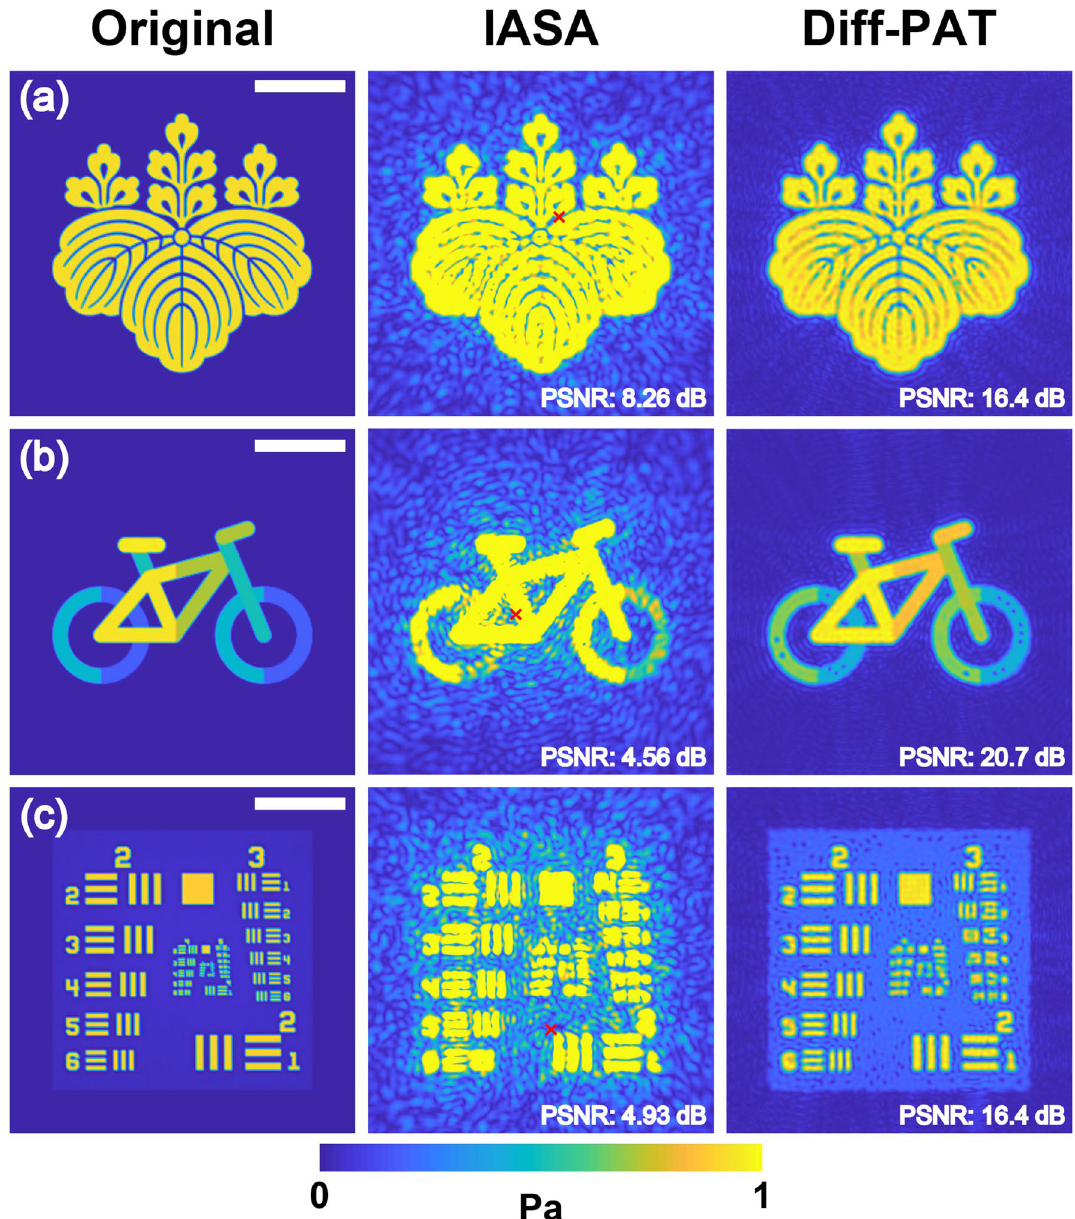
Figure 5. Comparison of acoustic holograms optimised using Diff-PAT and IASA. The resolution of the original image is 256 256 pixels. An underwater 2 MHz transducer with a 35 mm diameter was assumed, and × the pixel size was set to 150 µ m . ( a ) Emblem of the University of Tsukuba ( b ) a bicycle ( c ) USAF 1951 resolution test chart. The scale bar shows 10 mm. The images above are of absolute acoustic pressure amplitude, and are not normalized. The colour axis is limited between 0 to 1 Pa since the original test image is defined as such. Due to this, the image of IASA is saturated. Red crosses in IASA show the point of maximum pressure amplitude deviation. For images ( a )–( c ) in IASA, the maximum pressure amplitude deviations are 1.65, 4.75, and 3.12 Pa, respectively. Image created using MATLAB R2020b Update 2 (https:// www. mathw orks. com/ downl oads/), k-Wave (ver. 1.3 http:// www.k- wave. org/ downl oad. php) 56 and Adobe Illustrator 24.2.1 (https:// www. adobe. com/ produ cts/ illus trator.